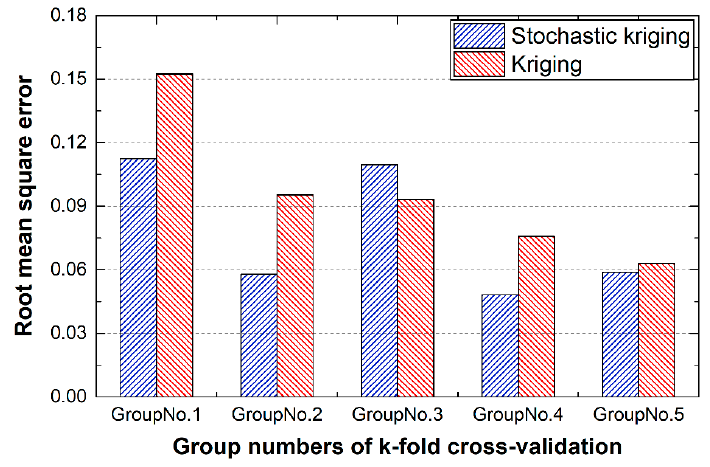
Figure 9. The comparison of RMSE between stochastic kriging model and kriging model.